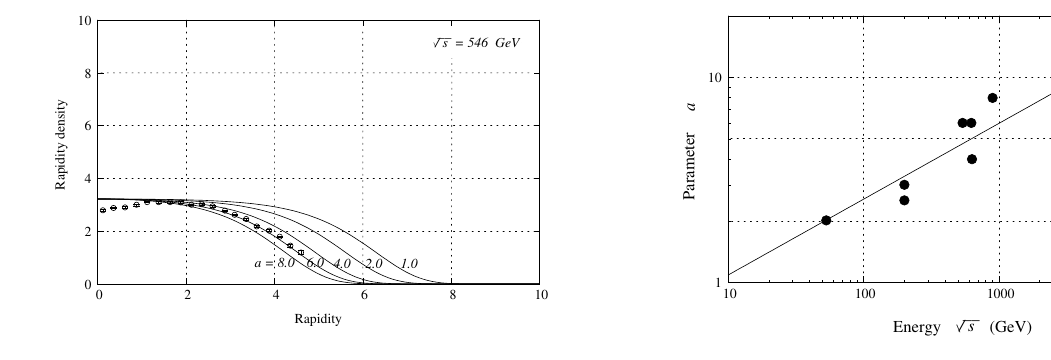
Figure 1. Rapidity density distribution at √ s = 546 GeV. Lines are eq.(6) for a = 1.0, 2.0, 4.0, 6.0 and 8.0. Experimental data are the pseudo-rapidity density from UA5 experiment.